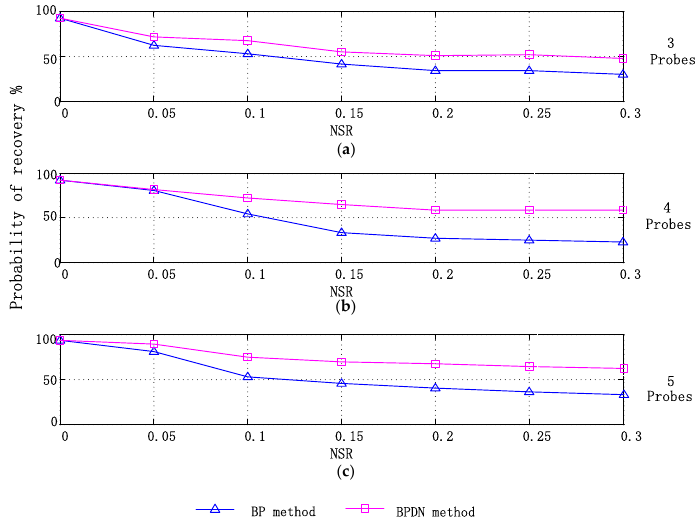
Figure 9. Reconstruction accuracy of BP and BPDN methods using ( a ) 3 probes ( b ) 4 probes ( c ) 5 probes.